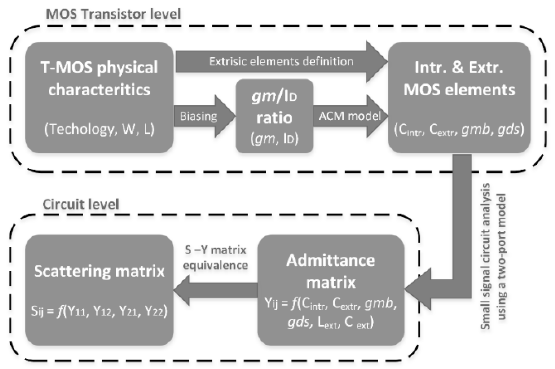
Figure 6. Procedure for obtaining S-parameters by means of the MOS physical characteristics.